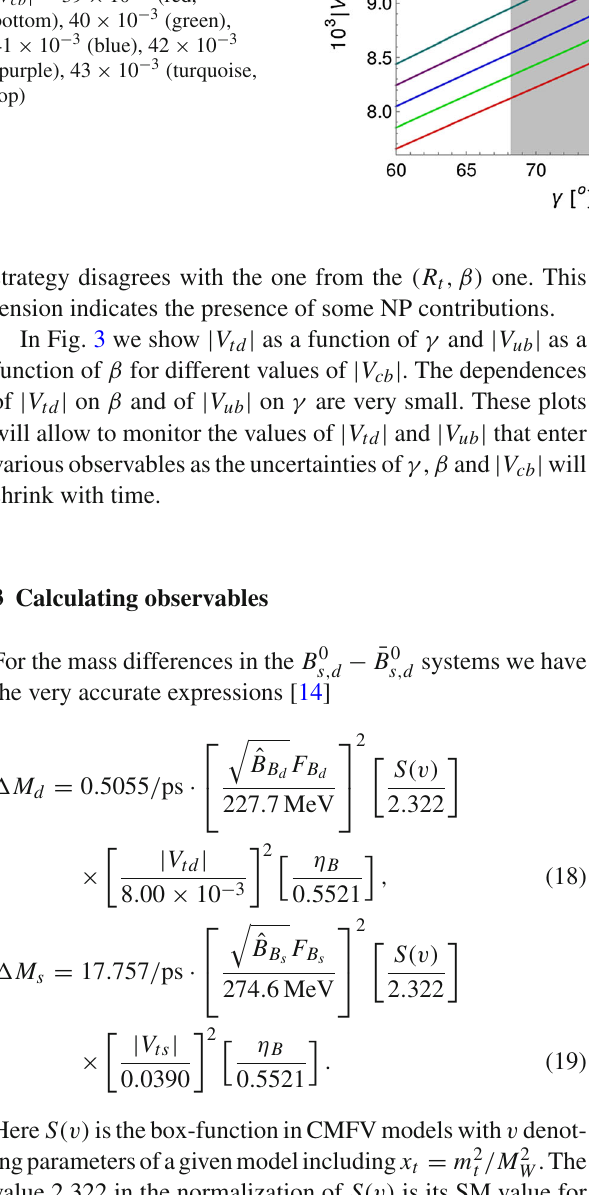
Fig. 3 Left: | V td | as function of γ , for different values of | V | . Right: | V | as function of cb ub β , for different values of | V | . cb The colours correspond to: | V | = 39 × 10 − 3 (red, cb bottom), 40 × 10 − 3 (green), 41 × 10 − 3 (blue), 42 × 10 − 3 (purple), 43 × 10 − 3 (turquoise, top)